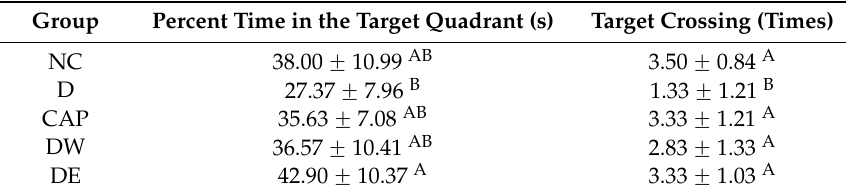
DE 42.90 ˘ 10.37 A 3.33 ˘ 1.03 A